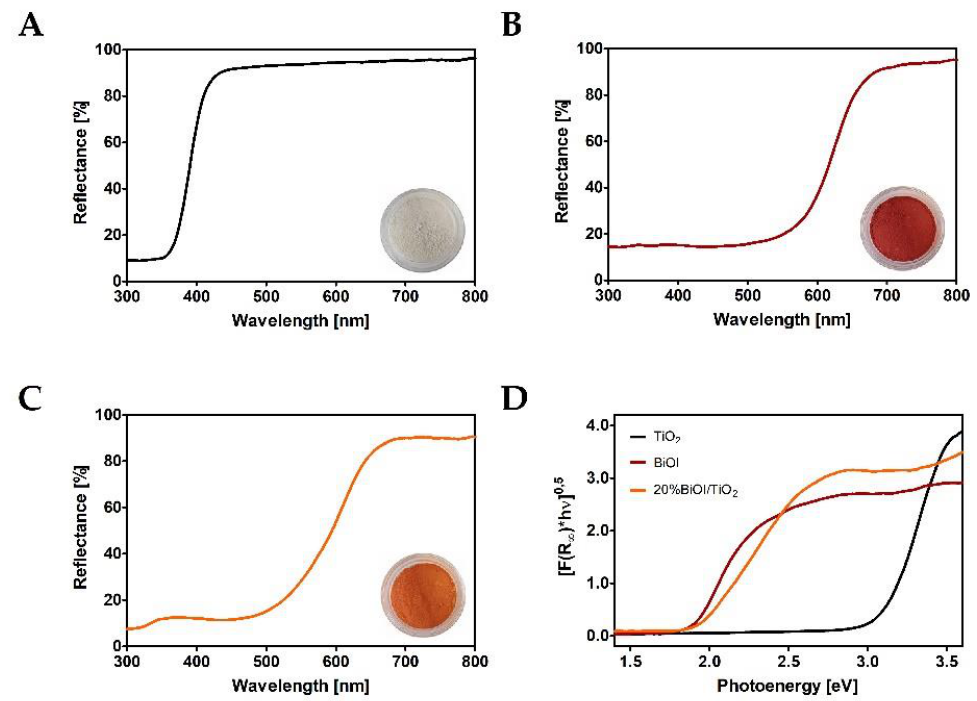
Figure 2. Diffuse reflectance spectra of ( A ) titanium dioxide; ( B ) bismuth oxyiodide; ( C ) 20% BiOI/TiO 2 ; ( D ) Tauc plots of synthesized photocatalysts samples. Insets show pictures of photocatalyst samples.